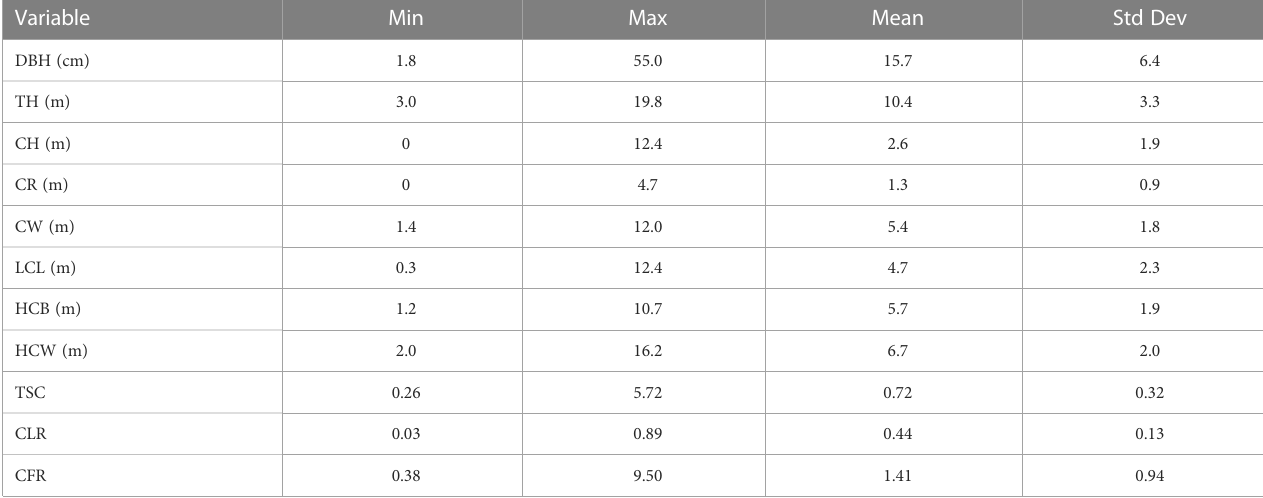
TABLE 2 Summary statistics of tree characteristic data for 516 sample trees. Variable